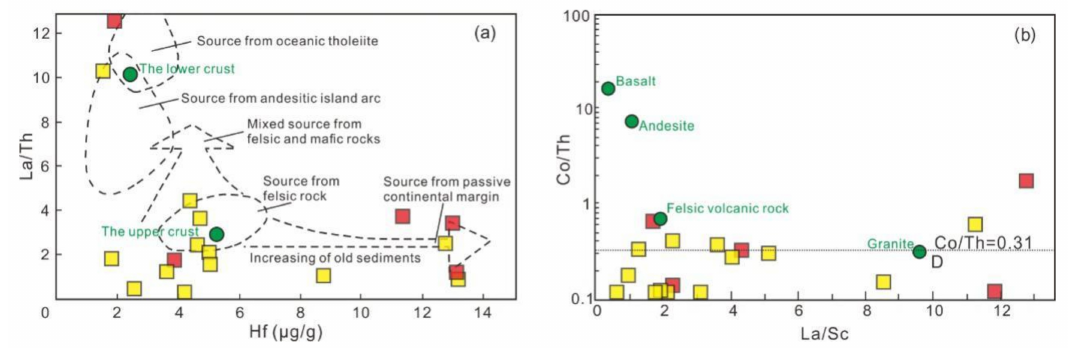
Figure 3. Diagrams of source apportionment for No. 9 coals. Red squares represented Ga-In-enriched horizons while yellow squares represented the rest of horizons. ( a ) was modified from Floyd and Leveridge [84]. ( b ) was modified from Gu et al.